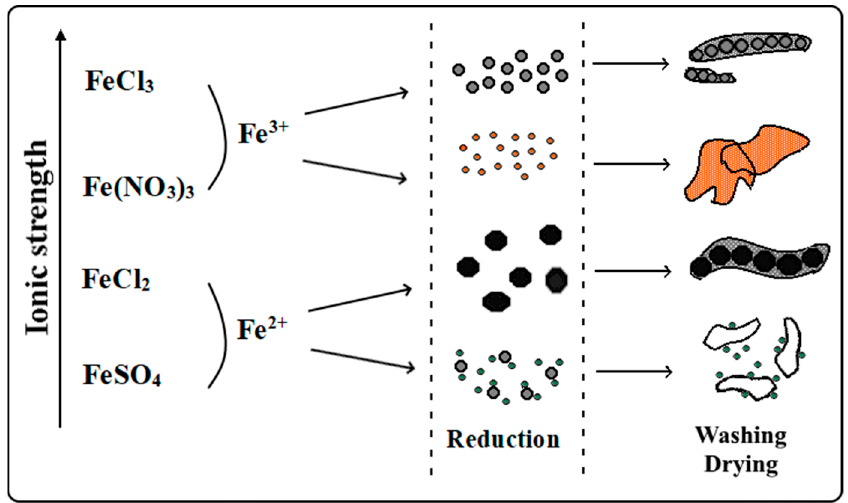
Figure 6. The scheme of the nZVI production via a borohydride reduction of different salts.